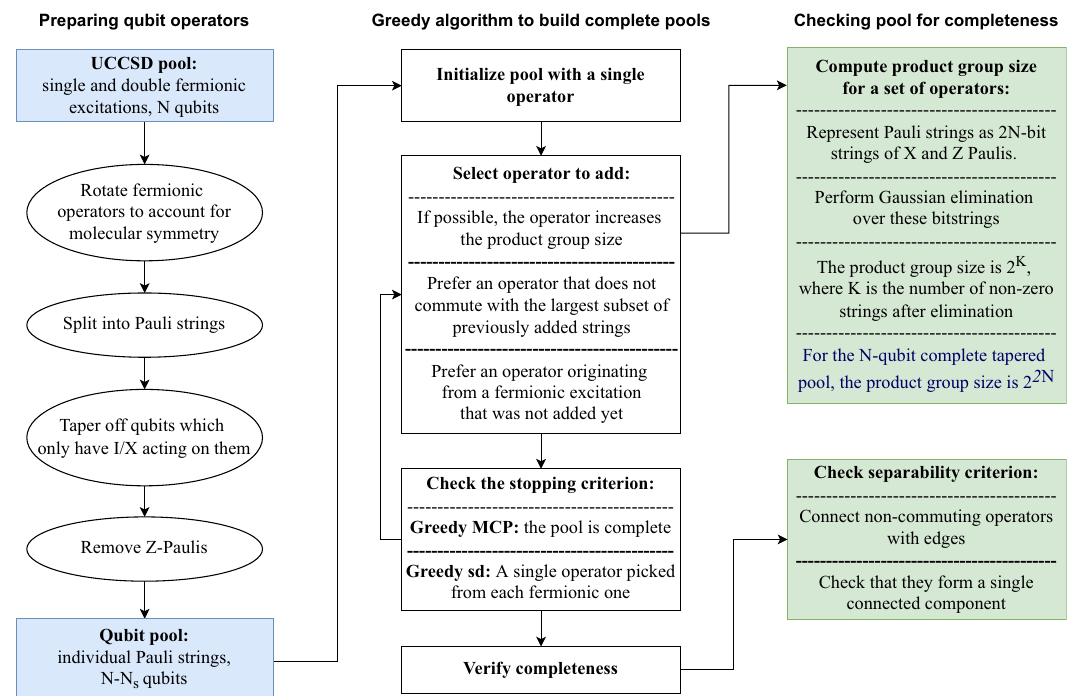
Fig. 2 Computational scheme of complete pool construction. The scheme is applicable for constructing qubit linear minimal complete pool (Greedy MCP) and qubit polynomial complete pool with Pauli strings originated from each single and double fermionic excitation (Greedy sd).